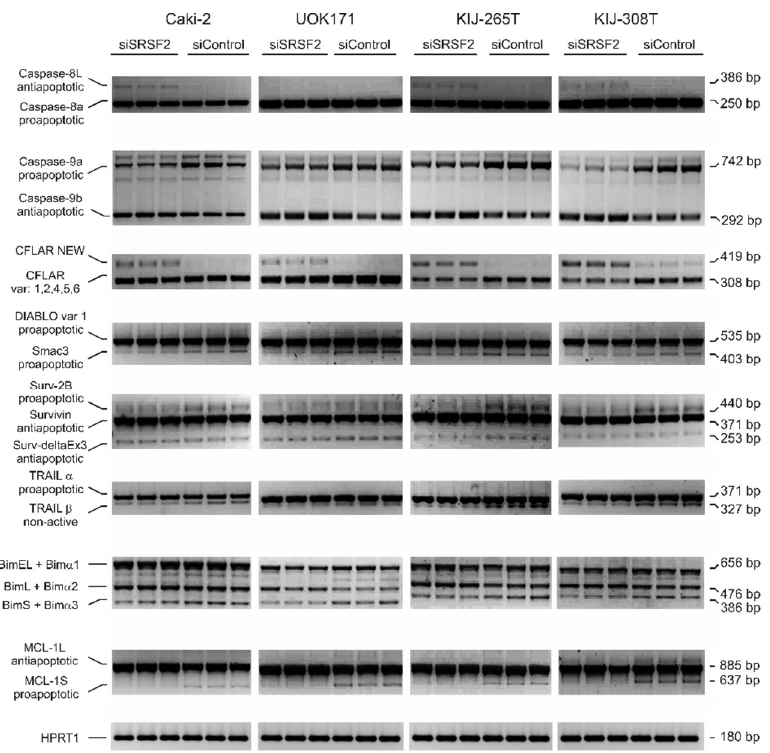
Figure 4. The effect of SRSF2 silencing on splicing patterns of apoptotic genes. Electrophoretic analysis of PCR-amplified splicing variants of apoptotic genes in four renal cancer-derived cell lines transfected with SRSF2-specific (siSRSF2) or control (siControl) siRNA. CFLAR NEW designates a new CFLAR splice variant, identified in this study. Primers used for amplification of BIM isoforms detected three major variants (BimEL, BimL, and BimS), as well as minor variants (Bimα1, Bimα2, and Bimα3). HPRT1—Internal RT-PCR control.